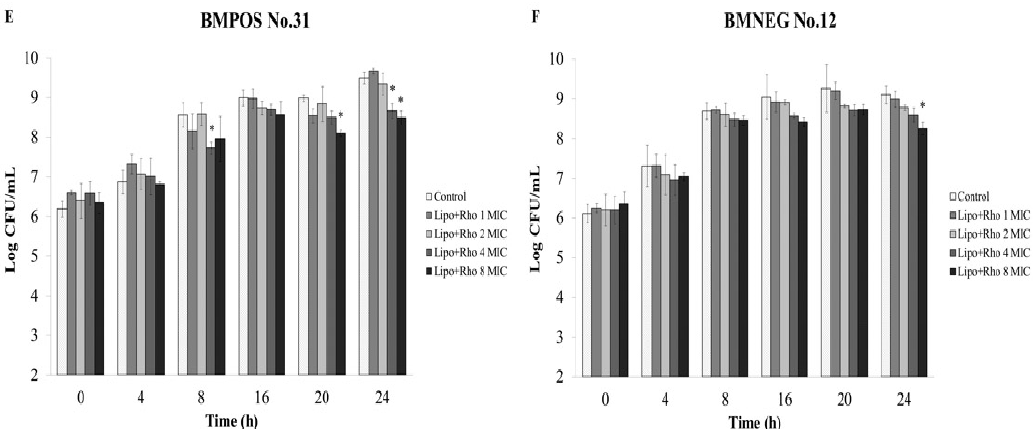
Figure 5. Quantification of the bacterial invasion using ex vivo anti ‐ infection assay. Each bar represents the number of invasive bacteria in the bovine udder tissue evaluated by a viable plate count. The bacterial transfected tissues were treated with 1 × minimum inhibitory concentration (MIC), 2 × MIC, 4 × MIC, and 8 × MIC of rhodomrtone; Rho ( A – C ) or liposome encapsulated rhodomyrtone; Lipo + Rho ( D – F ) at various time points (h). 1% DMSO was used as a control. The data represent the pooled results from two experiments and are expressed as a mean value ± standard deviation (SD). * p < 0.05, compared to the control.